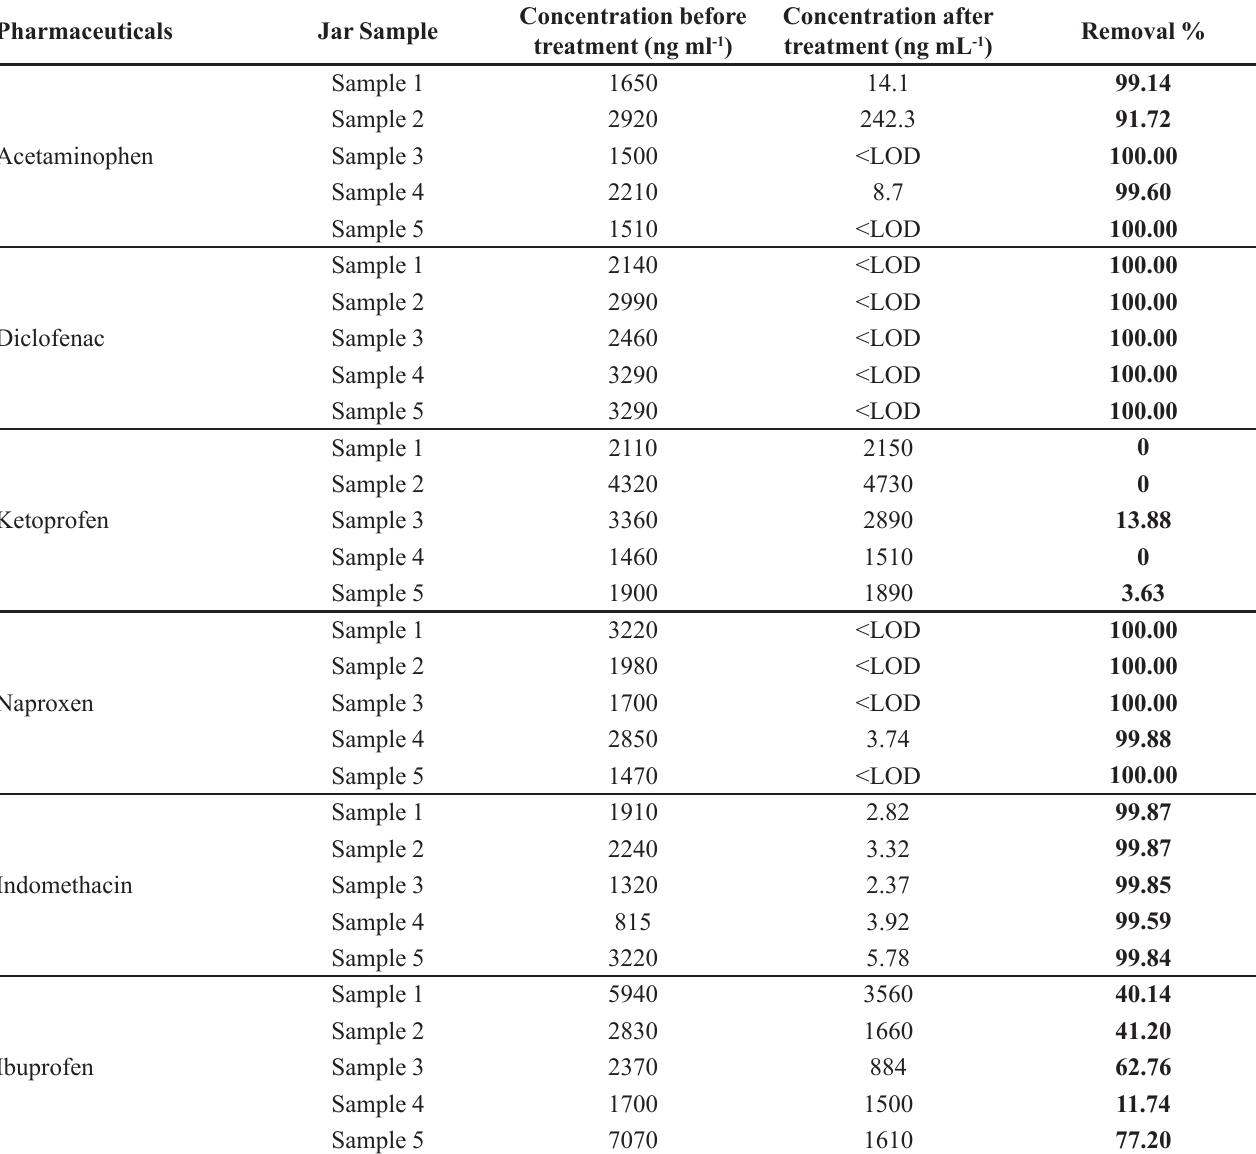
TABLE I - Percentage of removal of the evaluated compounds analyzed (in triplicates with SD <5% between them). Comparison of the peak areas before and after conventional treatment